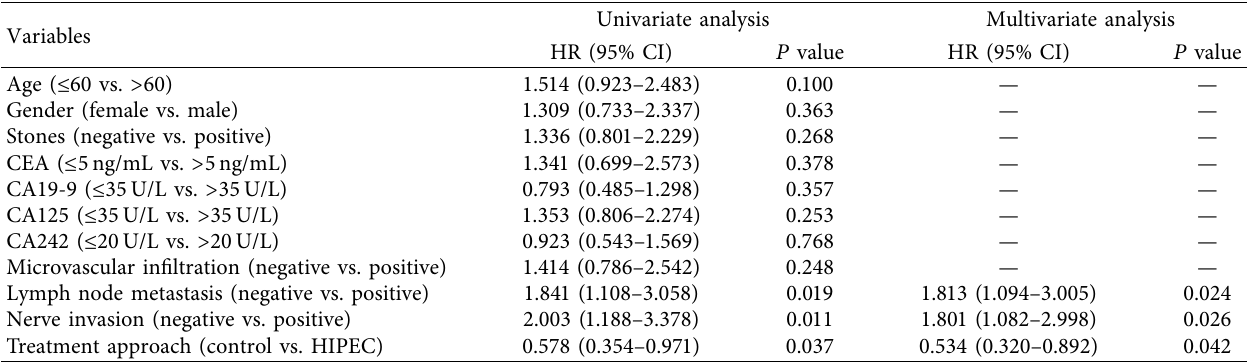
Table 3: Multivariate analysis of factors contributing to overall survival in 78 GBC